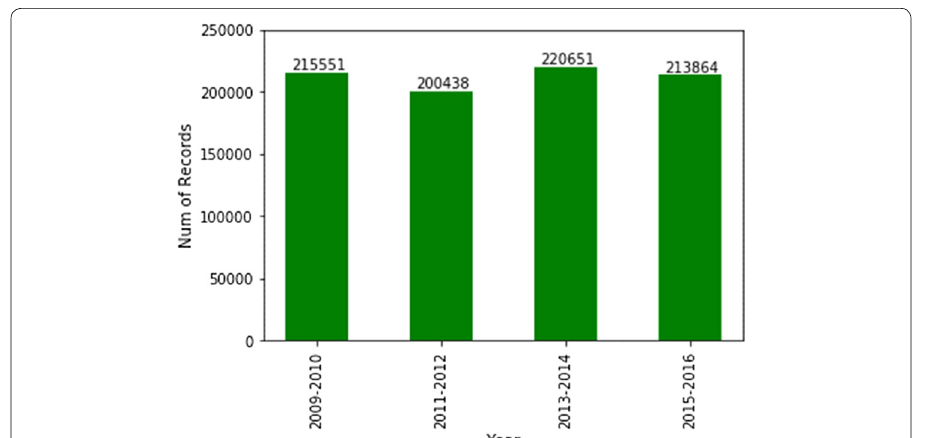
Fig. 9 Number of patients by NHANES survey year